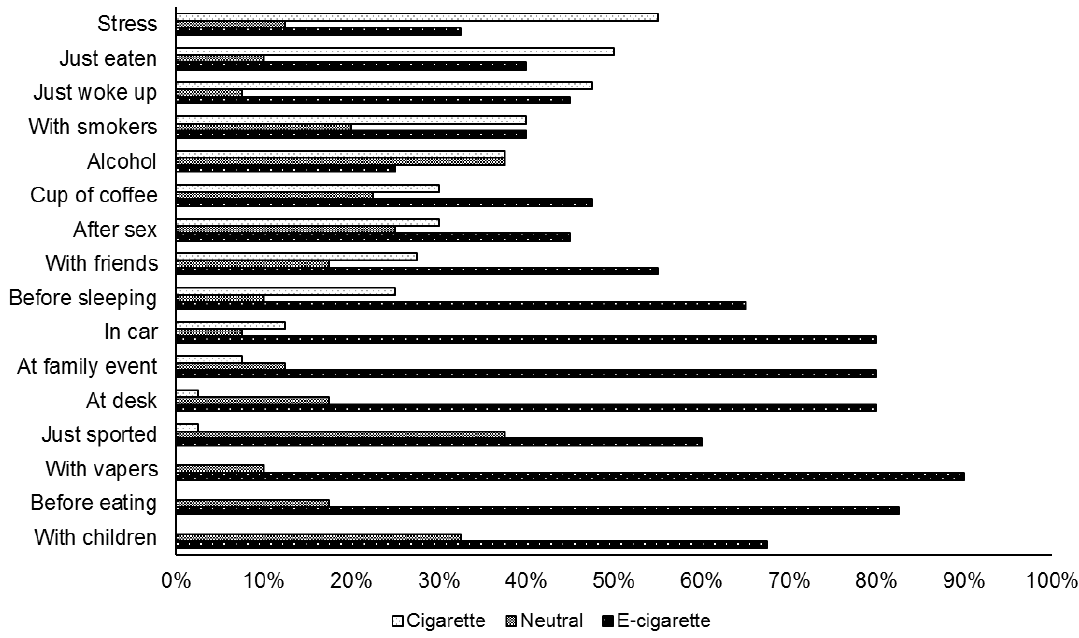
Figure 1. Situations in which dual users prefer cigarettes vs. e-cigs.